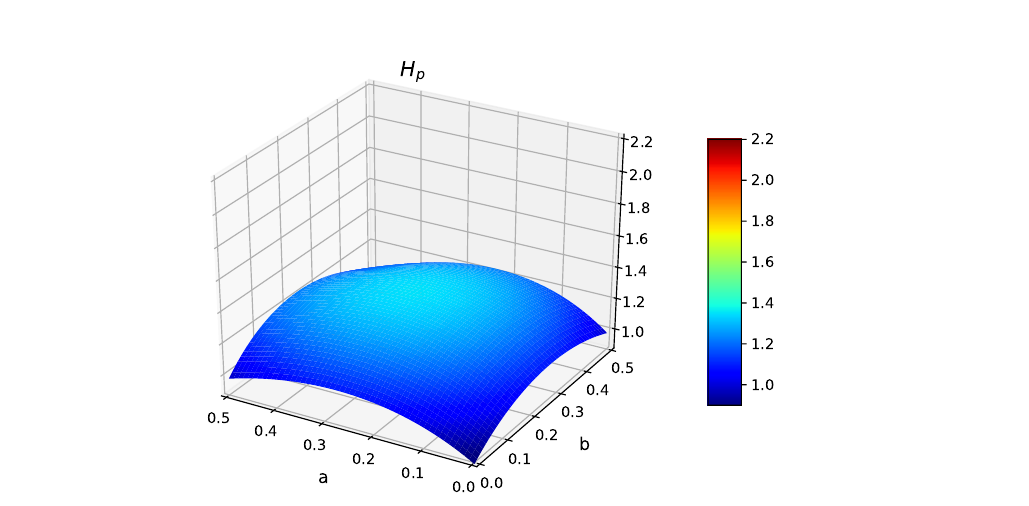
Figure 1. The change of uncertainty values in Example 5.